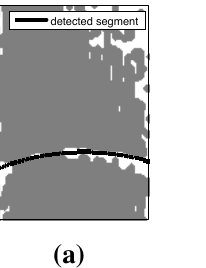
Figure 4. ( a ) Image with Gaussian and Salt and Pepper added in levels of 0.1; ( b ) Results from Sobel filter; ( c ) Results from vesselness filter.